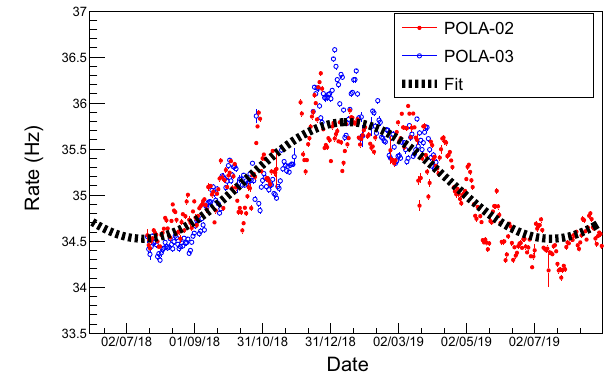
Fig. 5 POLA-02 and POLA-03 (x1.01) measured cosmic particle rate as a function of time, for the period from July 7, 2018 to August 31, 2019. A fit to the data, after normalisation, is superimposed